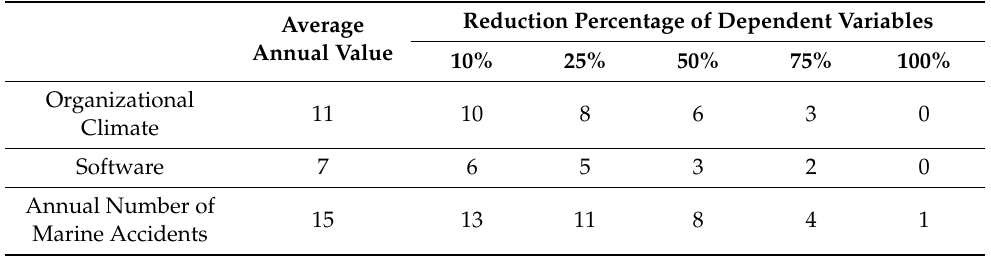
Table 8. Effect of explanatory variables values reduction on the number of marine accidents.